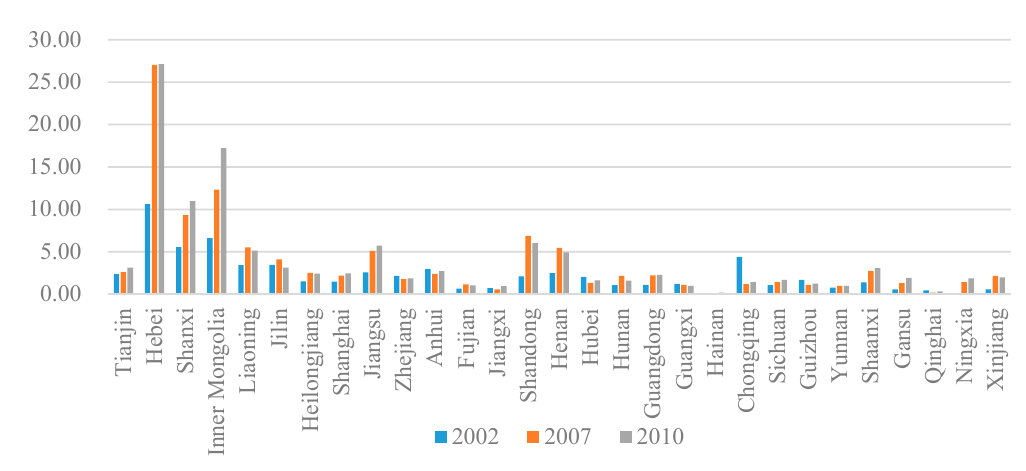
Figure 1. Embodied carbon flowed in Beijing from other provinces in 2002, 2007, and 2010 (million tons).